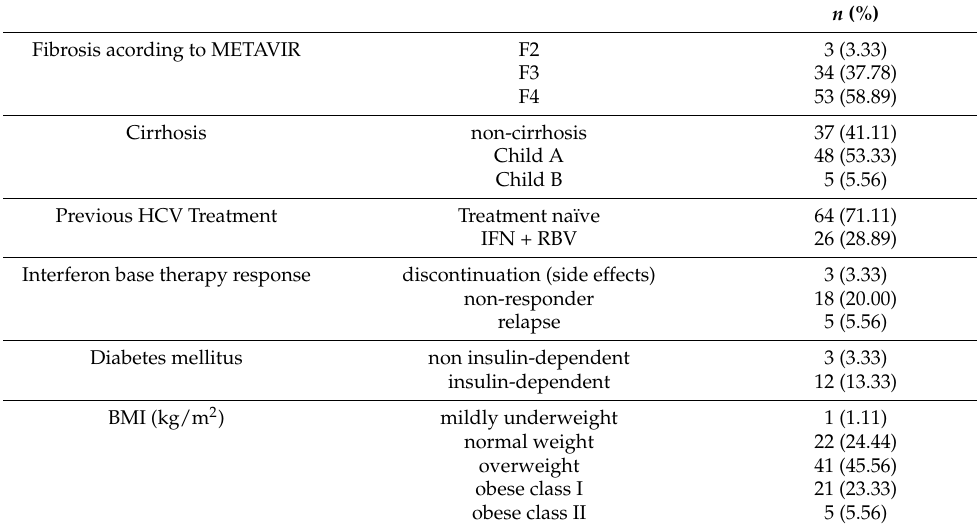
Table 2. Patients’ clinical status